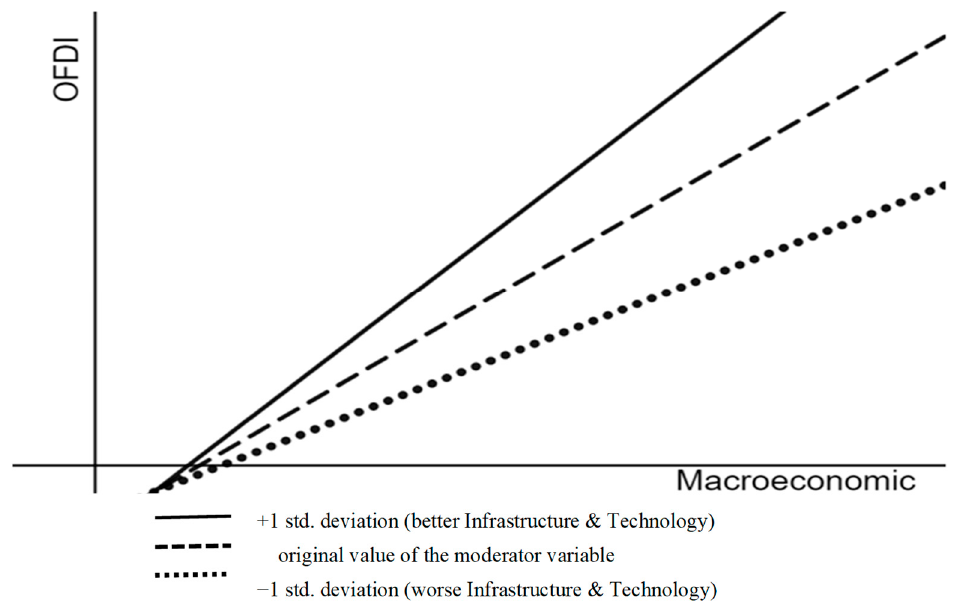
Figure 3. The positive moderating effects of home country formal institutions on the relationship between the macroeconomic performance and OFDI intensity from